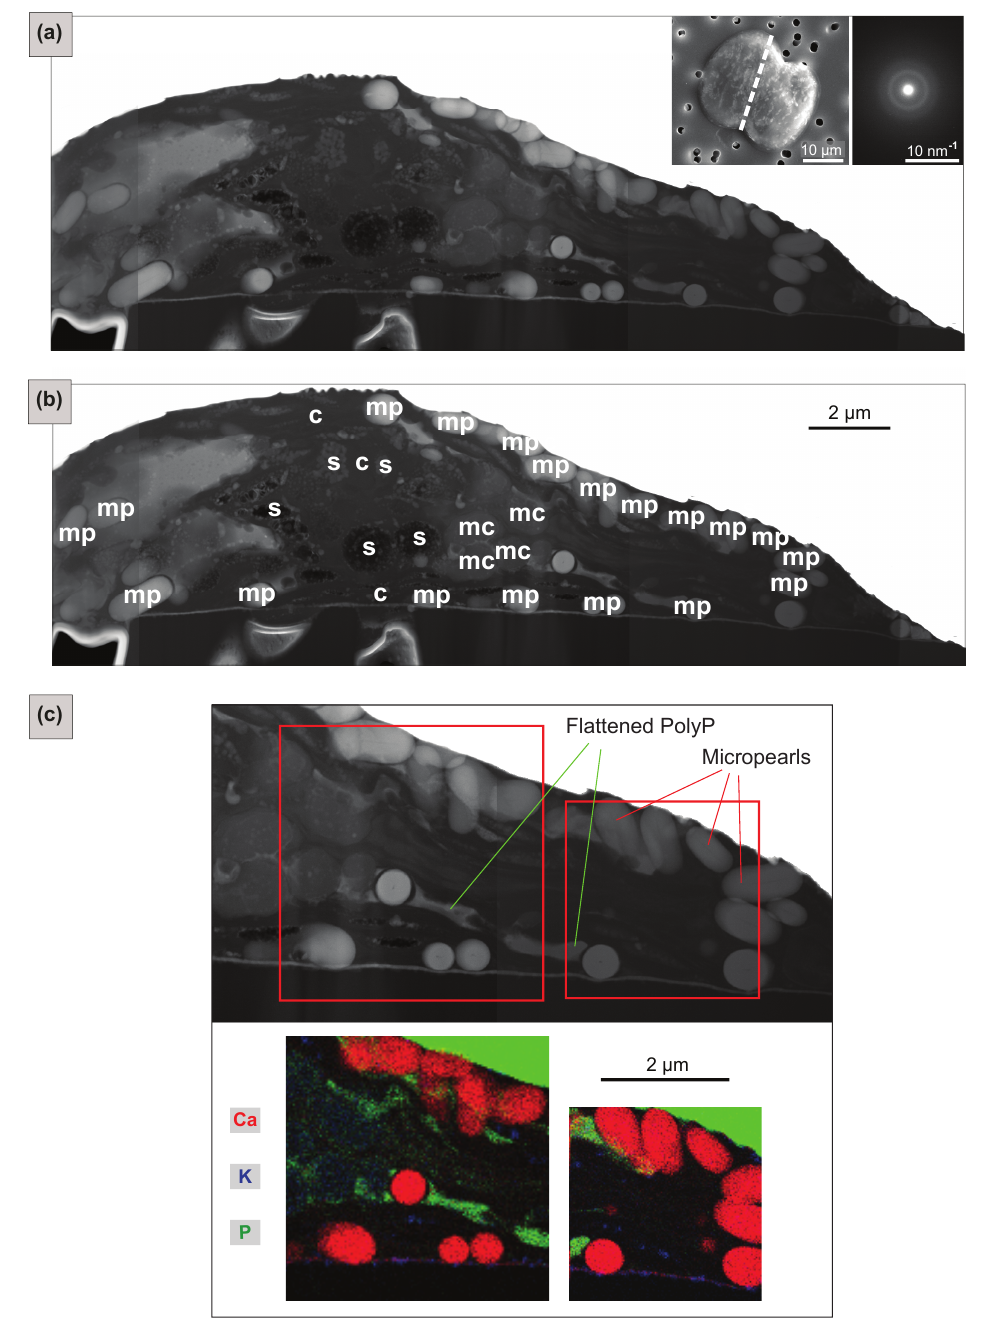
Figure 3. FIB-cut section through a Tetraselmis contracta cell (dried sample). (a) TEM–HAADF image of the whole FIB-cut section. The micropearls show light or medium grey shades and regular round or oval shapes. Left top inset: SEM secondary image of the whole cell before it was cut, with a dashed line indicating the location of the section. Right top inset: SAED patterns from a single micropearl of this FIB-cut section (diffuse diffraction rings are indicative for amorphous material). (b) Tentative identification of the visible cellular constituents; s: starch grains; c: chloroplast; mp: micropearls; mc: mitochondria. See Fig. S7 for a detailed image. (c) TEM–EDXS mappings – the top image shows the location of the two zones on a TEM–HAADF image of the section. The map shows an RGB image with three superimposed element mappings. Micropearls are mainly composed of Ca, with small quantities of K (and Mg, not shown here). Note that, due to the overlap between the P K peak and secondary Pt L peak, the Pt layer, which was deposited on top of the sample during FIB preparation, is also visible in